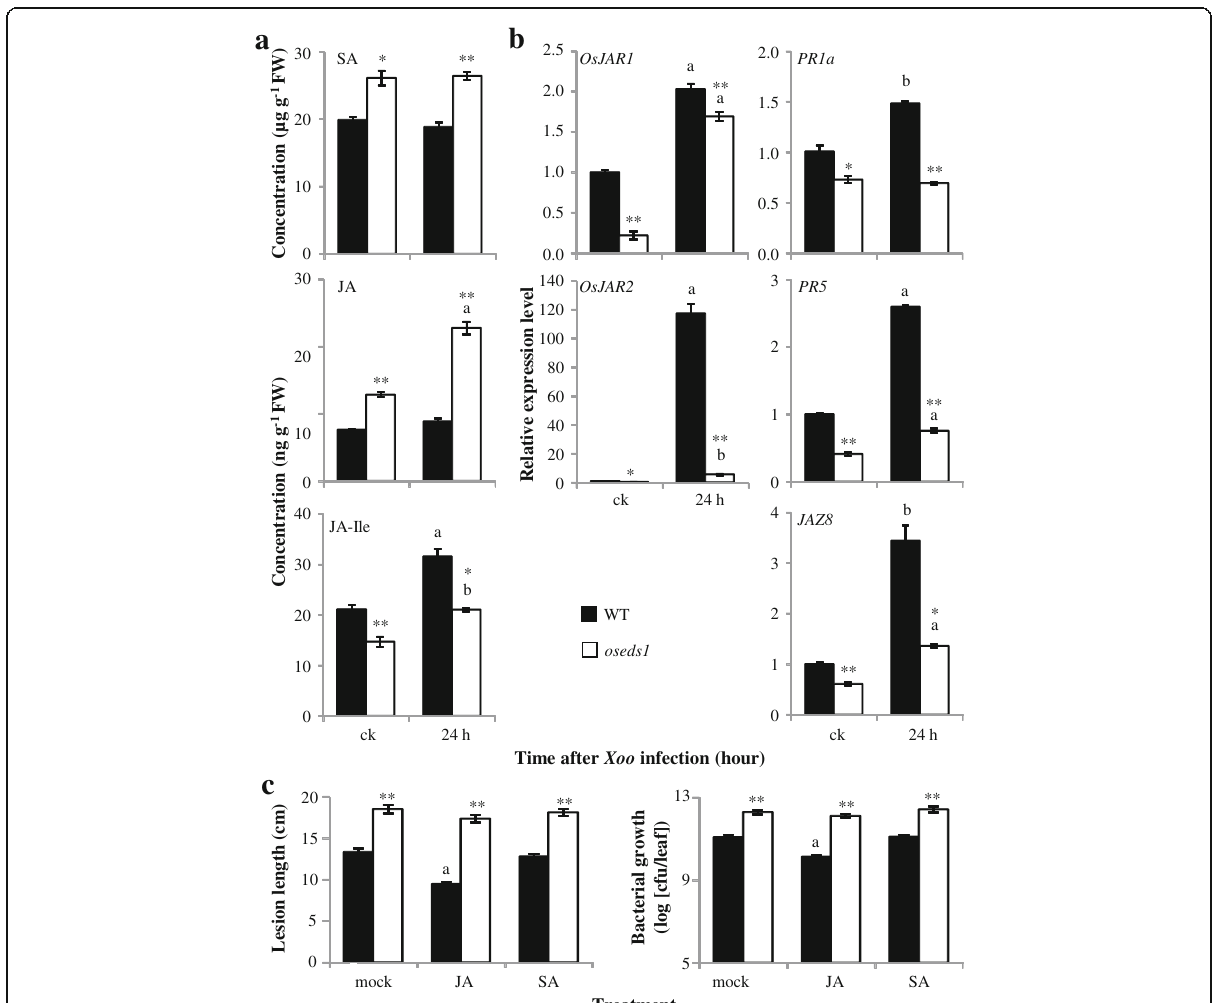
Fig. 6 The oseds1 mutant performance response to Xoo inoculation and hormone treatment. Two-tail student ’ s t-test. ** and * above bar indicate significant differences between oseds1 and wild-type (WT) plants after the same treatment at P <0.01 and P <0.05, respectively. The “ a ” and “ b ” above bar indicate significant differences between un-infection (ck) and infection plants at P <0.01 and P <0.05, respectively. FW, fresh weight. a Hormone content in oseds1 . Bars represent mean±SE ( n =3). b Genes expression in oseds1 . Bars represent mean±SE ( n =3). c Exogenous application of JA or SA did not reduce the susceptibility of oseds1 mutant to Xoo invasion. Bacterial growth was analyzed at 12days after Xoo infection. Bars represent mean±SE ( n =30 to 38 for lesion length, and 3 for bacterial